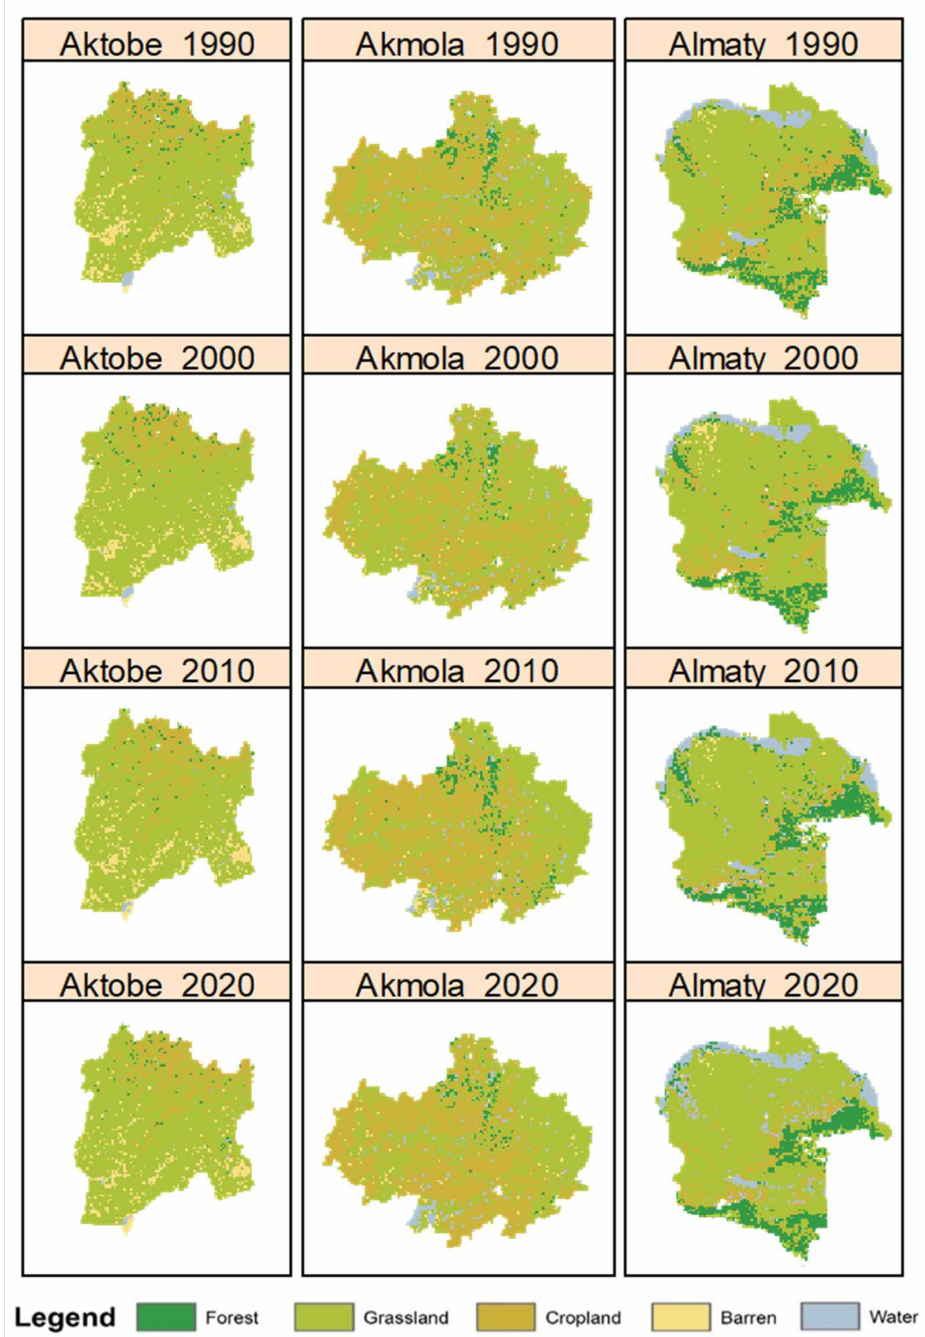
Figure A1. Classified land cover maps for the three provinces in